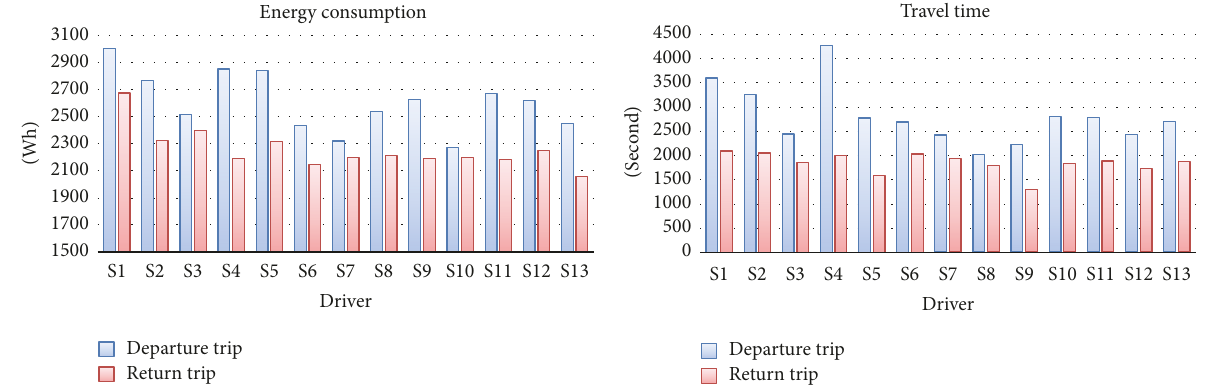
Figure 4: Energy consumption and time cost for all drivers.